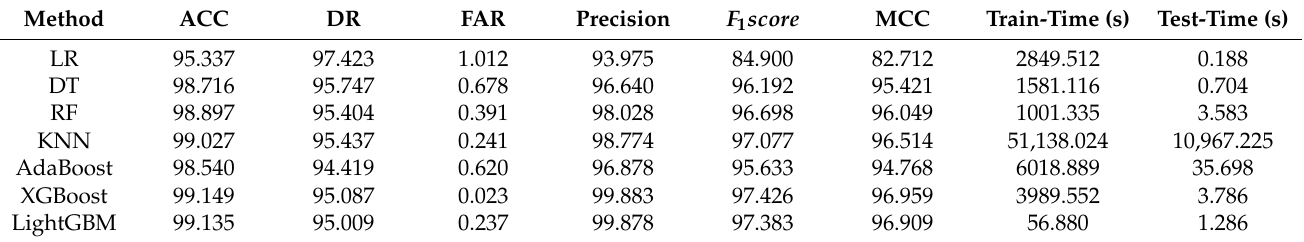
Table 4. Performance evaluation of multiple machine learning algorithms in Stage-1